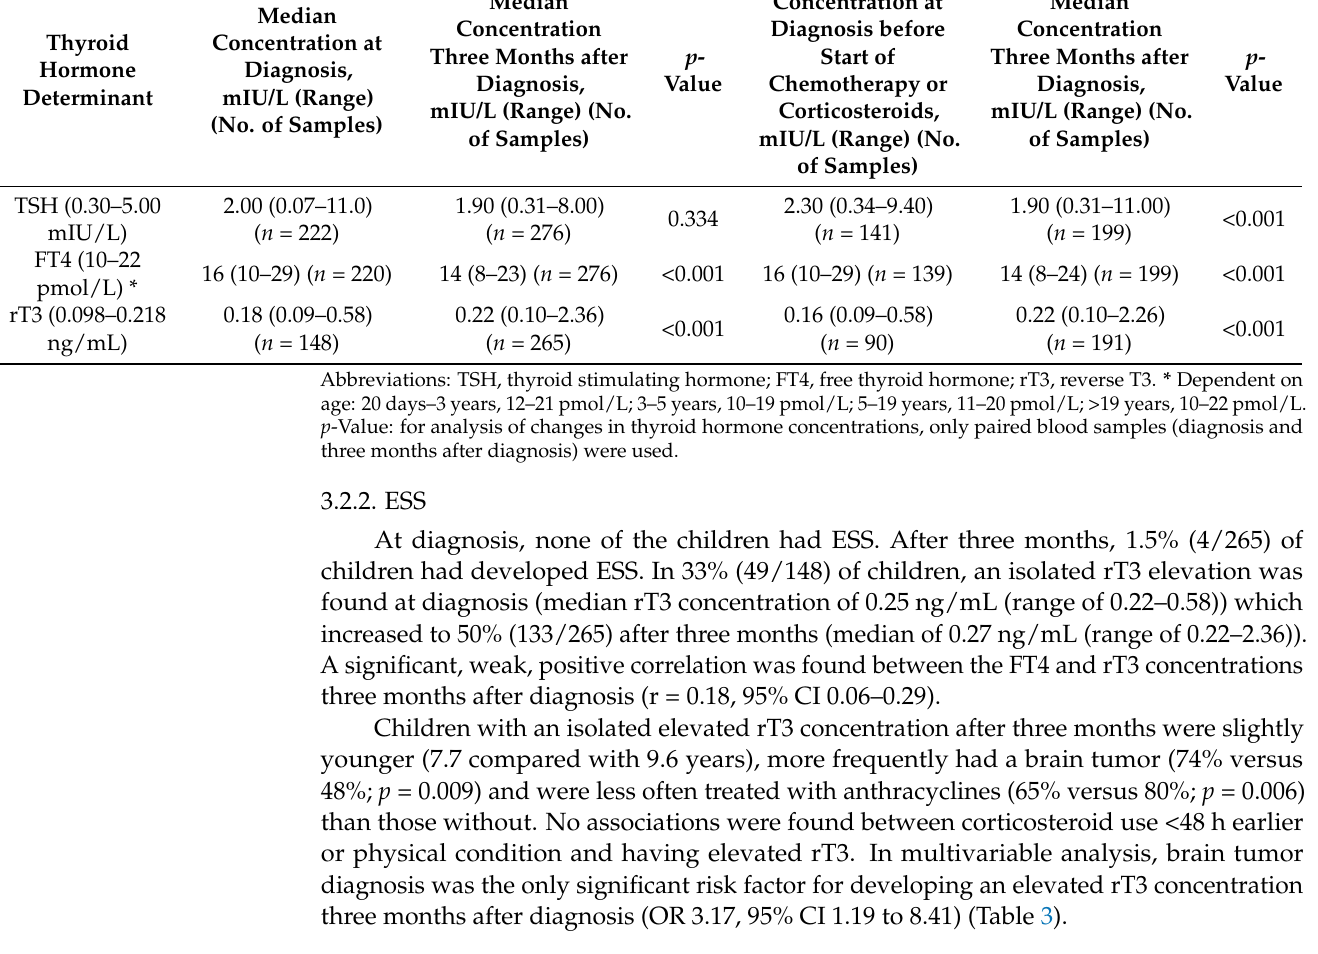
Table 3. Risk factor analysis